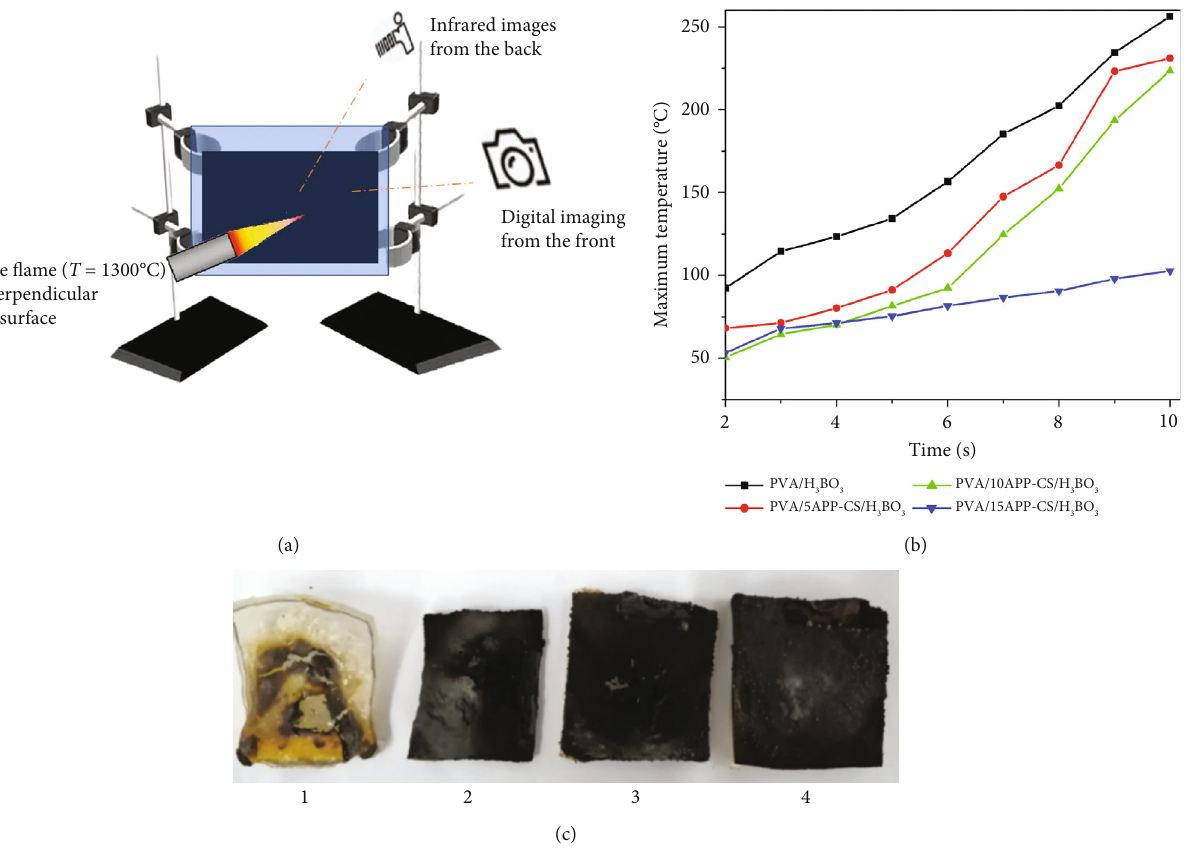
Figure 12: Fire resistance of the PVA-based aerogels. (a) Schematic of the fi re resistance test. (b) Maximum temperature at the back of the aerogels versus time. (c) Photographs of the samples after burning for 10